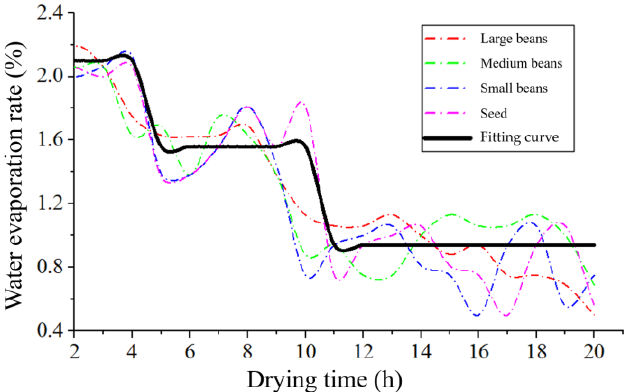
Figure 3. Drying characteristics curve of Cyperus esculentus .